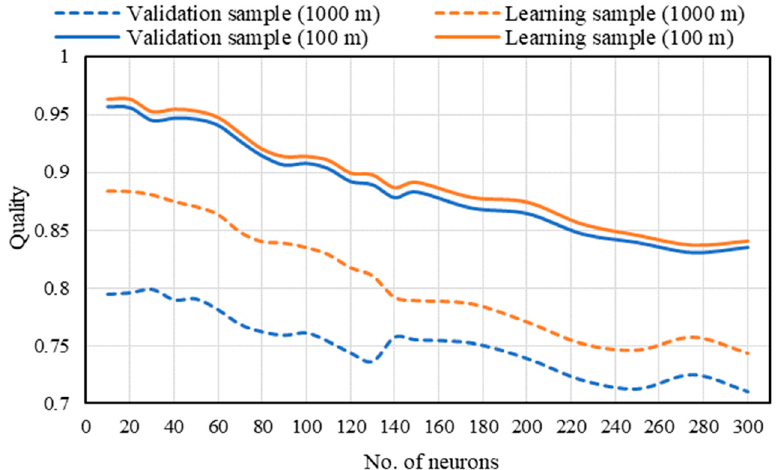
Figure 8 . Average quality of the validation sample based on the number of neurons in the hidden layer for two sizes of primary field.